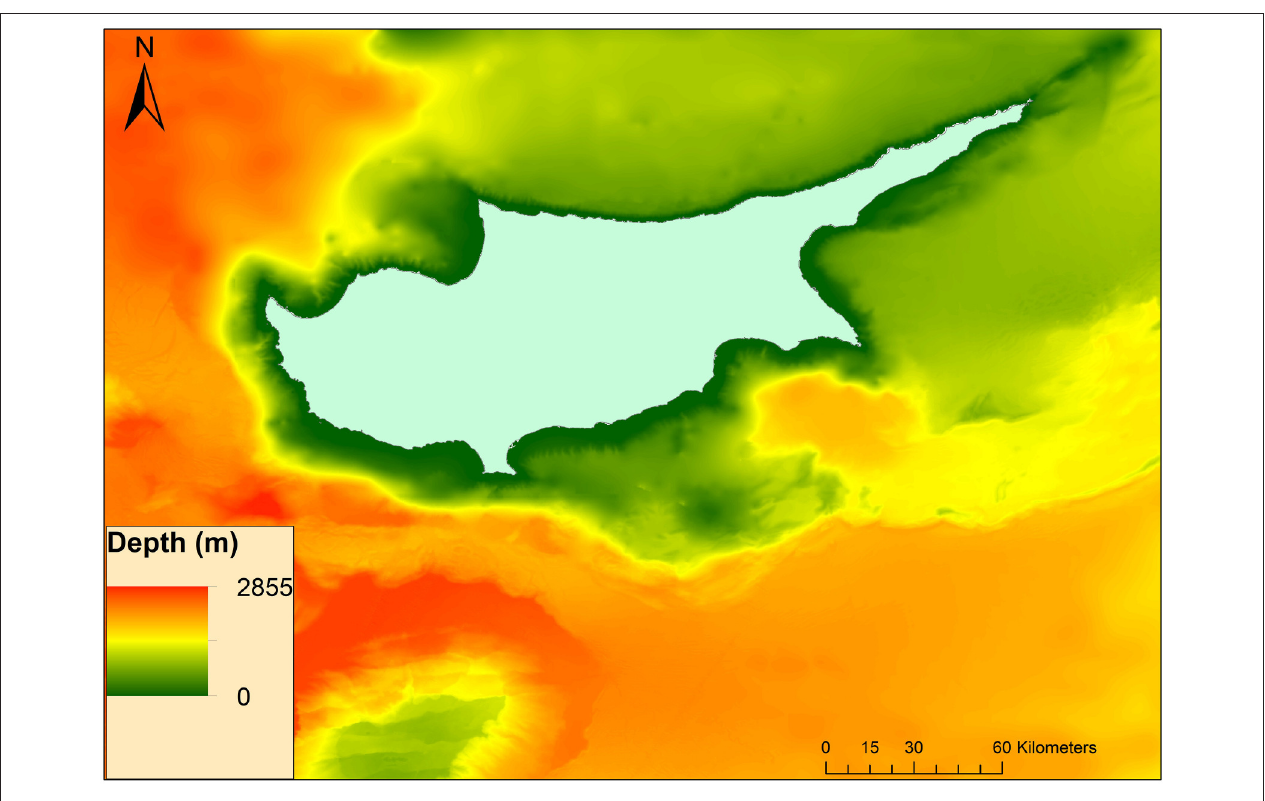
FIGURE 9 | Bathymetry around